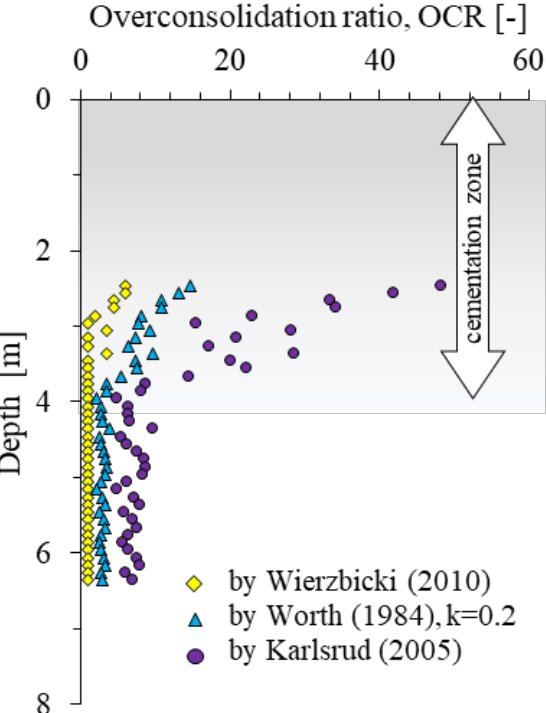
Figure 7. Overconsolidation-ratio values determined by the Wierzbicki [66], Worth [67] and Karlsrud [68] formulas based on CPTU test.